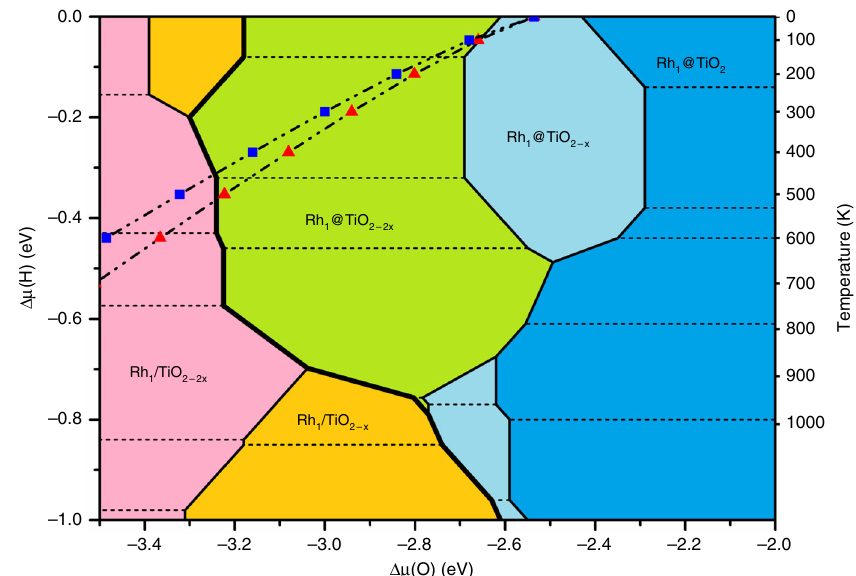
Fig. 3 Surface stability diagram for Rh single atom on TiO 2 (110) in the presence of H 2 . Axes represent the H and O chemical potentials (noted Δ µ (H) and Δ µ (O) in eV). Different colors indicate the various con fi gurations for the Rh and the TiO 2 surface, where blue, light blue, and green denote regions where Rh is preferentially substituting a six-coordinated surface Ti with zero, one, or two O vacancies (Rh 1 @TiO 2 , Rh 1 @TiO 2 – x , Rh 1 @TiO 2 − 2 × ) and orange and pink zones where the supported Rh structure is favored (Rh 1 /TiO 2 − x and Rh 1 /TiO 2 − 2 × ), respectively. The amount of hydrogen adsorbed on the TiO 2 surface and the Rh atom depends on Δ µ (H) and dash lines limit the zones corresponding to different hydrogen coverage (see Supplementary Fig. 6). The red triangle (blue square) line shows the relation between Δ μ (O) and Δ μ (H) when water formation reaction is included with 0.01% (0.001%) conversion. Δ μ (H) values for 0.1 atm H 2 and various temperatures are shown on the right vertical axis